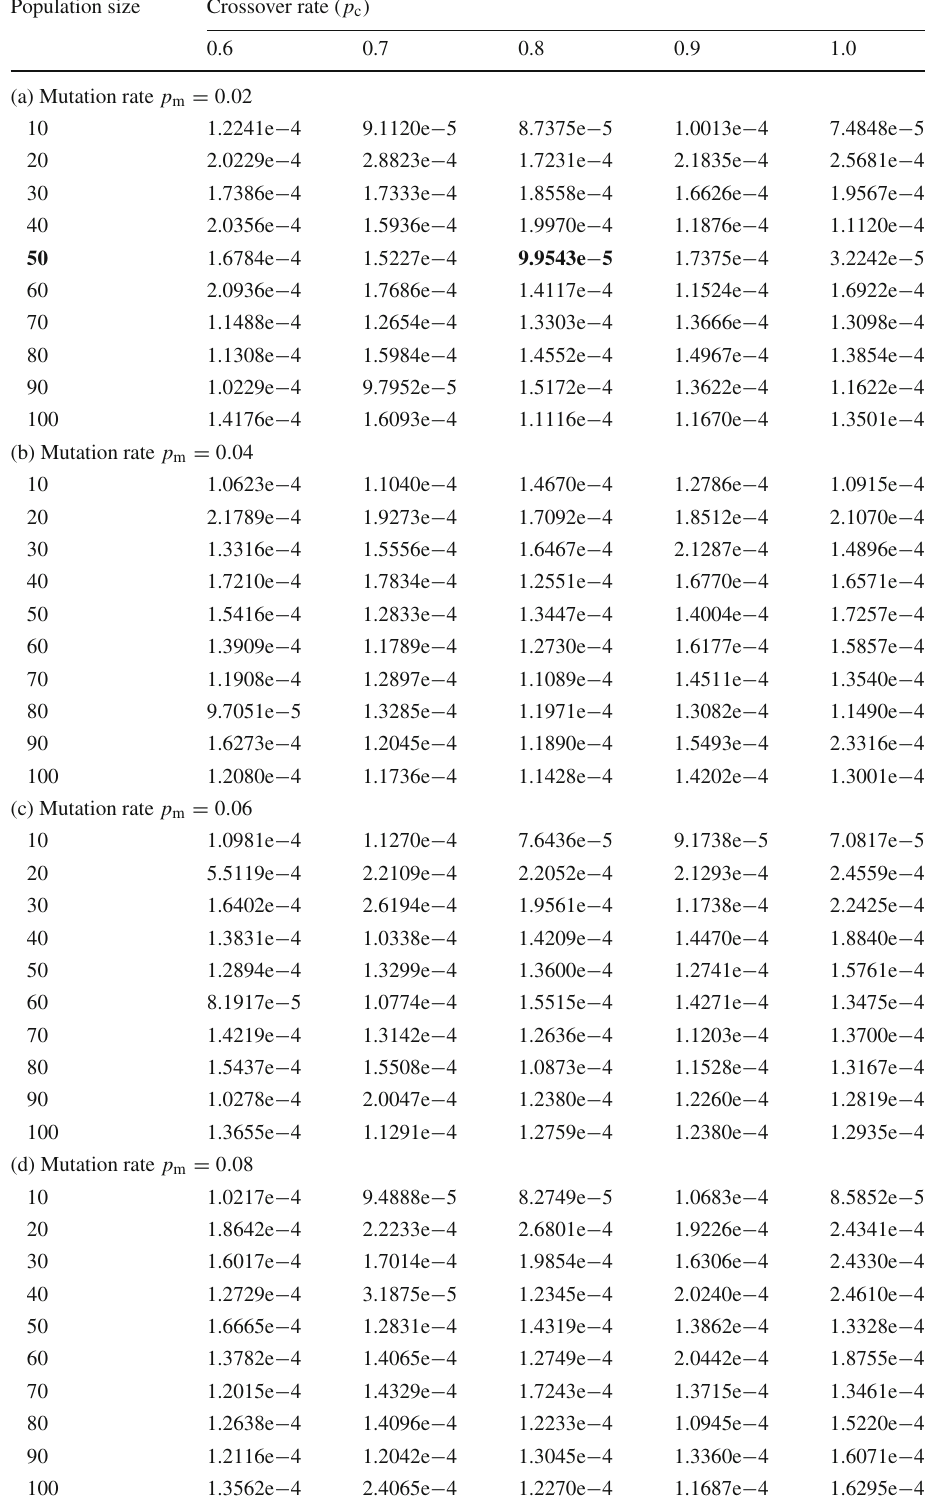
Table 3 Determination of optimum GA